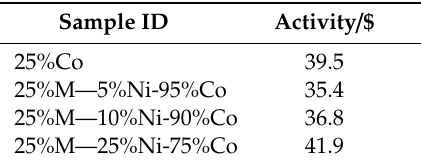
Table 4. Activity / $ at steady-state conditions for the tested